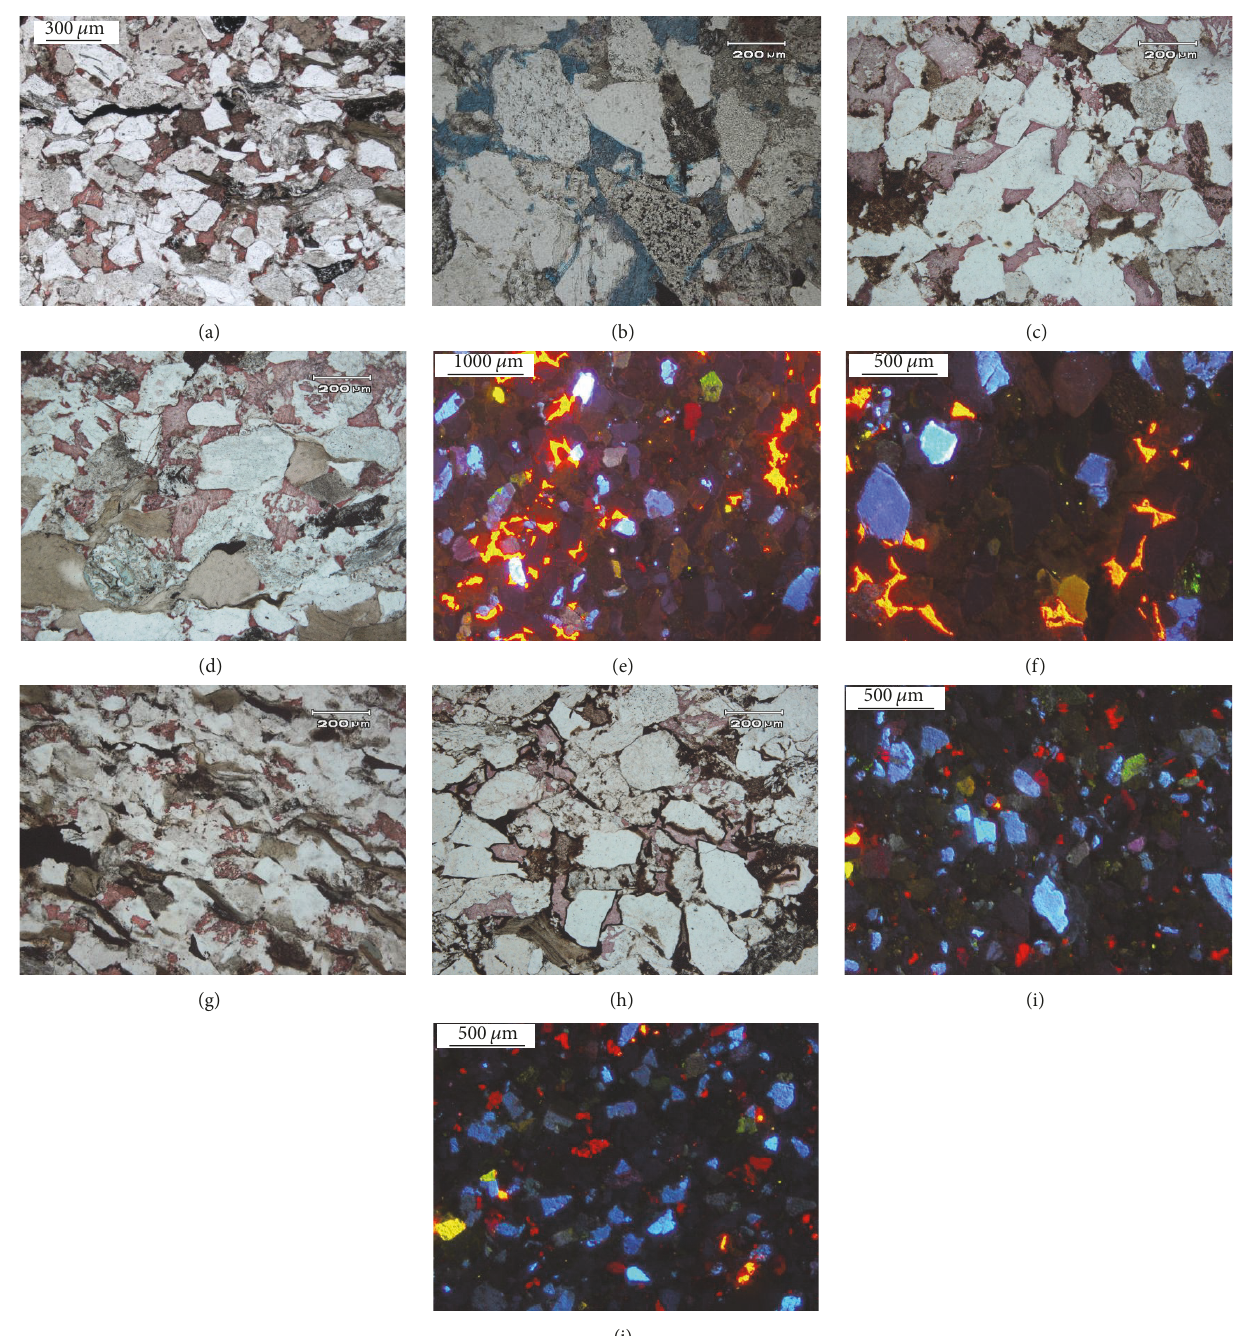
Figure 7: Photomicrographs showing the petrography, geochemistry, and distribution of carbonate cement for Chang 8 sandstones in Ordos basin; (a) calcites are the dominant pore-filling constituents, and they also replace framework grains; intergranular macropores are rarely observed in this sandstone, Zhuang 75, 2116 m, PPL; (b) dolomites are the most common pore-filling constituents. Dolomite also replaces framework grains, Yuan 43, 2270.56 m, PPL; (c) calcite fills large intergranular pores between loosely packed framework grains and replaces the framework grains, Luo 1, 2499.07 m; (d) calcite fills large intergranular pores between loosely packed framework grains and replaces the framework grains, Feng 9, 2512.92 m; (e) Type I calcites fill large pores between loosely packed framework grains, which display bright orange-red and yellow luminescence patterns, Zhuang 214, 1890.37 m, Cathode Luminescence (CL); (f) Type I calcites display bright orange- red and yellow luminescence patterns, Zhuang 214, 1890.37 m, CL; (g) Type II calcites occupy much smaller intergranular pores in tightly packed sandstones and replaced the detrital grains, An 62, 2396.47 m, PPL; (h) Type II calcites occupy much smaller intergranular pores in tightly packed sandstones and replaced the detrital grains, Luo 13, 2750.62, PPL; (i) Type II calcites occupy much smaller intergranular pores in tightly packed sandstones, and they precipitate along the edge of the preexisting Type I carbonate cement, and they display a weak dull red/orange and blotchy luminescence, Zhuang 240, 1785.6 m, CL; (j) Type II calcites display a weak dull red/orange and blotchy luminescence, Zhuang 214, 1782.85 m,